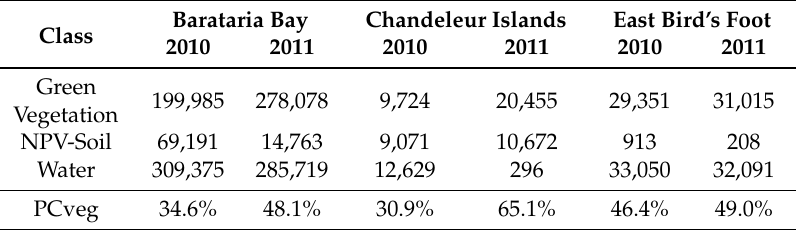
Table 4. Change in total classified area from 2010 to 2011 for each study site. Area of each class is in m 2 (each pixel = 59.3 m 2 for Barataria Bay and Chandeleur Islands and 11.56 m 2 for East Bird’s Foot). PCveg is the overall percentage of green vegetation from 2010 to 2011 for each study site along the oiled shorelines. As the buffer zone includes both the landward side and seaward side, having roughly 50% green vegetation would indicate a good recovery on the landward side of the shoreline; greater than 50% recovery indicates water pixels becoming vegetated. Barataria Bay Chandeleur Islands East Bird’s Class